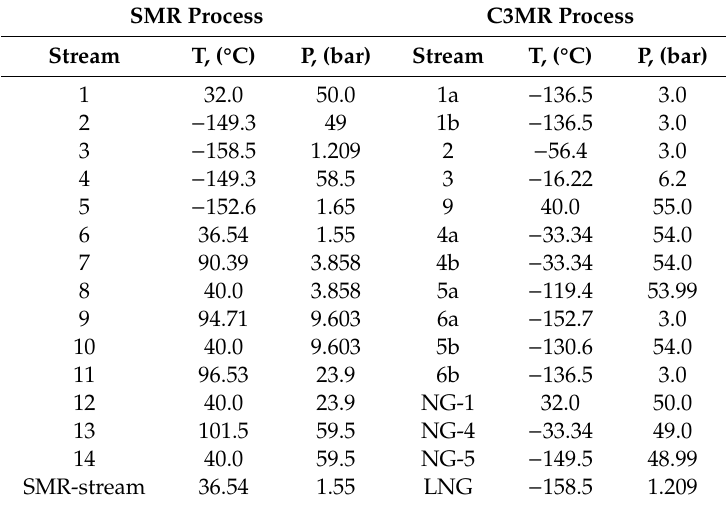
Table 5. Temperature and pressure for all streams of SMR and C3MR processes.